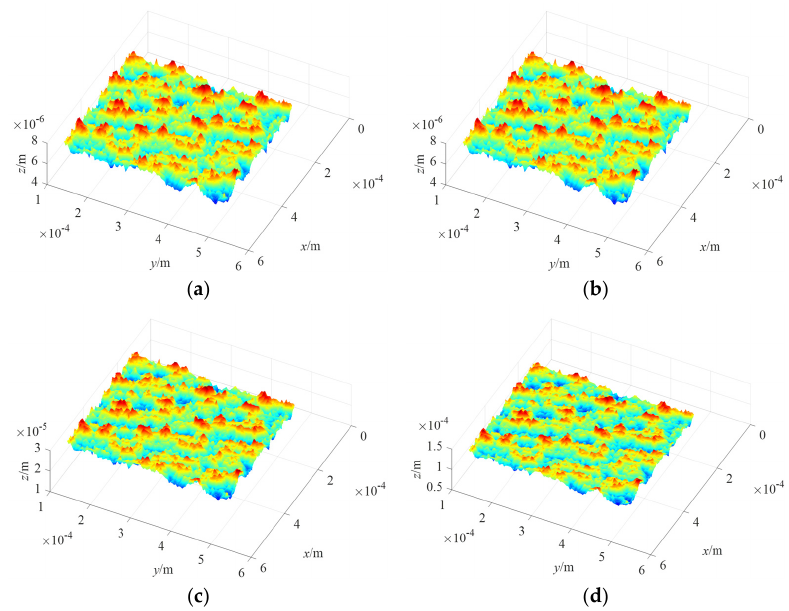
Figure 3. Generated rough surfaces with different G values: ( a ) G = 1 × 10 − 8 m; ( b ) G = 1 × 10 − 7 m; ( c ) G = 1 × 10 − 6 m; ( d ) G = 1 × 10 − 5